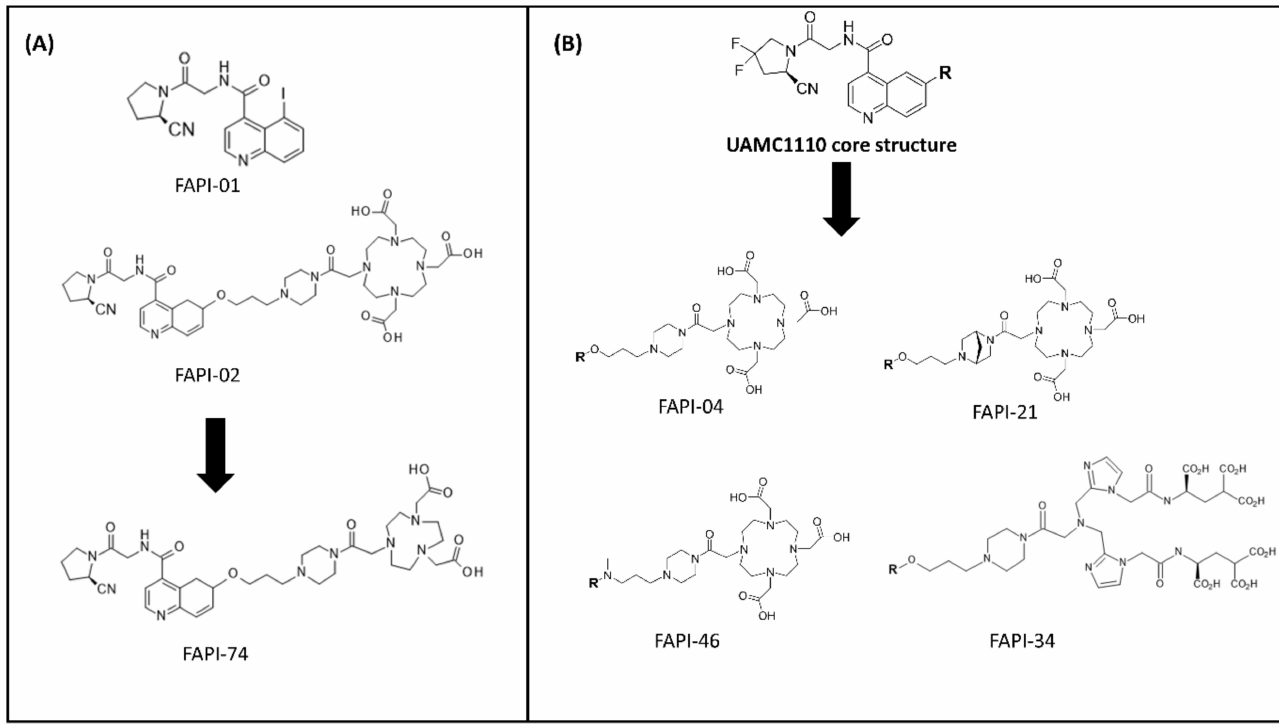
Figure 6. Examples of FAPI molecules developed by the Heidelberg group. ( A ) The first generation of FAPIs (FAPI-01 and FAPI-02) and subsequent work on FAPI-74 using the same FAP-targeting moiety conjugated NOTA chelator. ( B ) Relevant FAPI molecules based on UAMC1110 scaffold, including FAPI-04, FAPI-21, FAPI-34, and